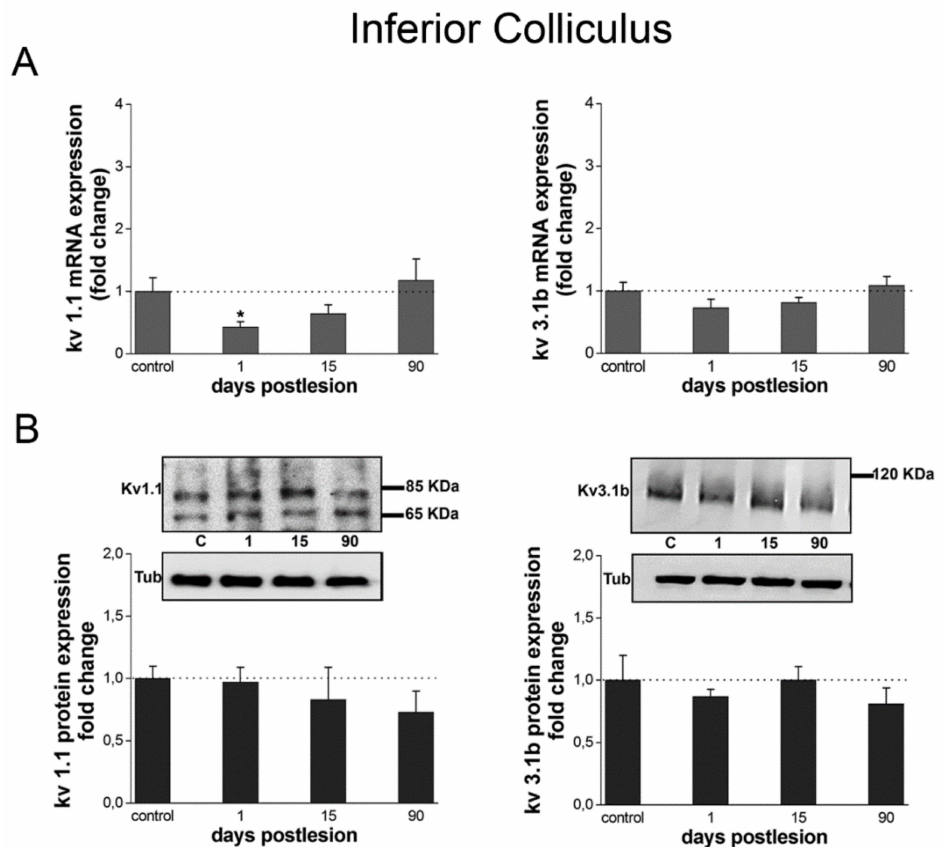
Figure 6. Kv1.1 and Kv3.1b gene and protein levels undergo little or no changes in the IC after cochlear lesion. ( A ) Kv1.1 and Kv3.1b mRNA levels at di ff erent time points after the lesion analyzed by